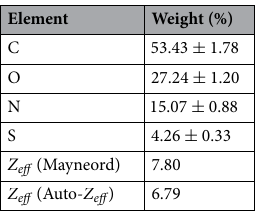
Table 1. Z eff calculations based on the average elemental compositions of single strand hair sample subjected to EDX mapping